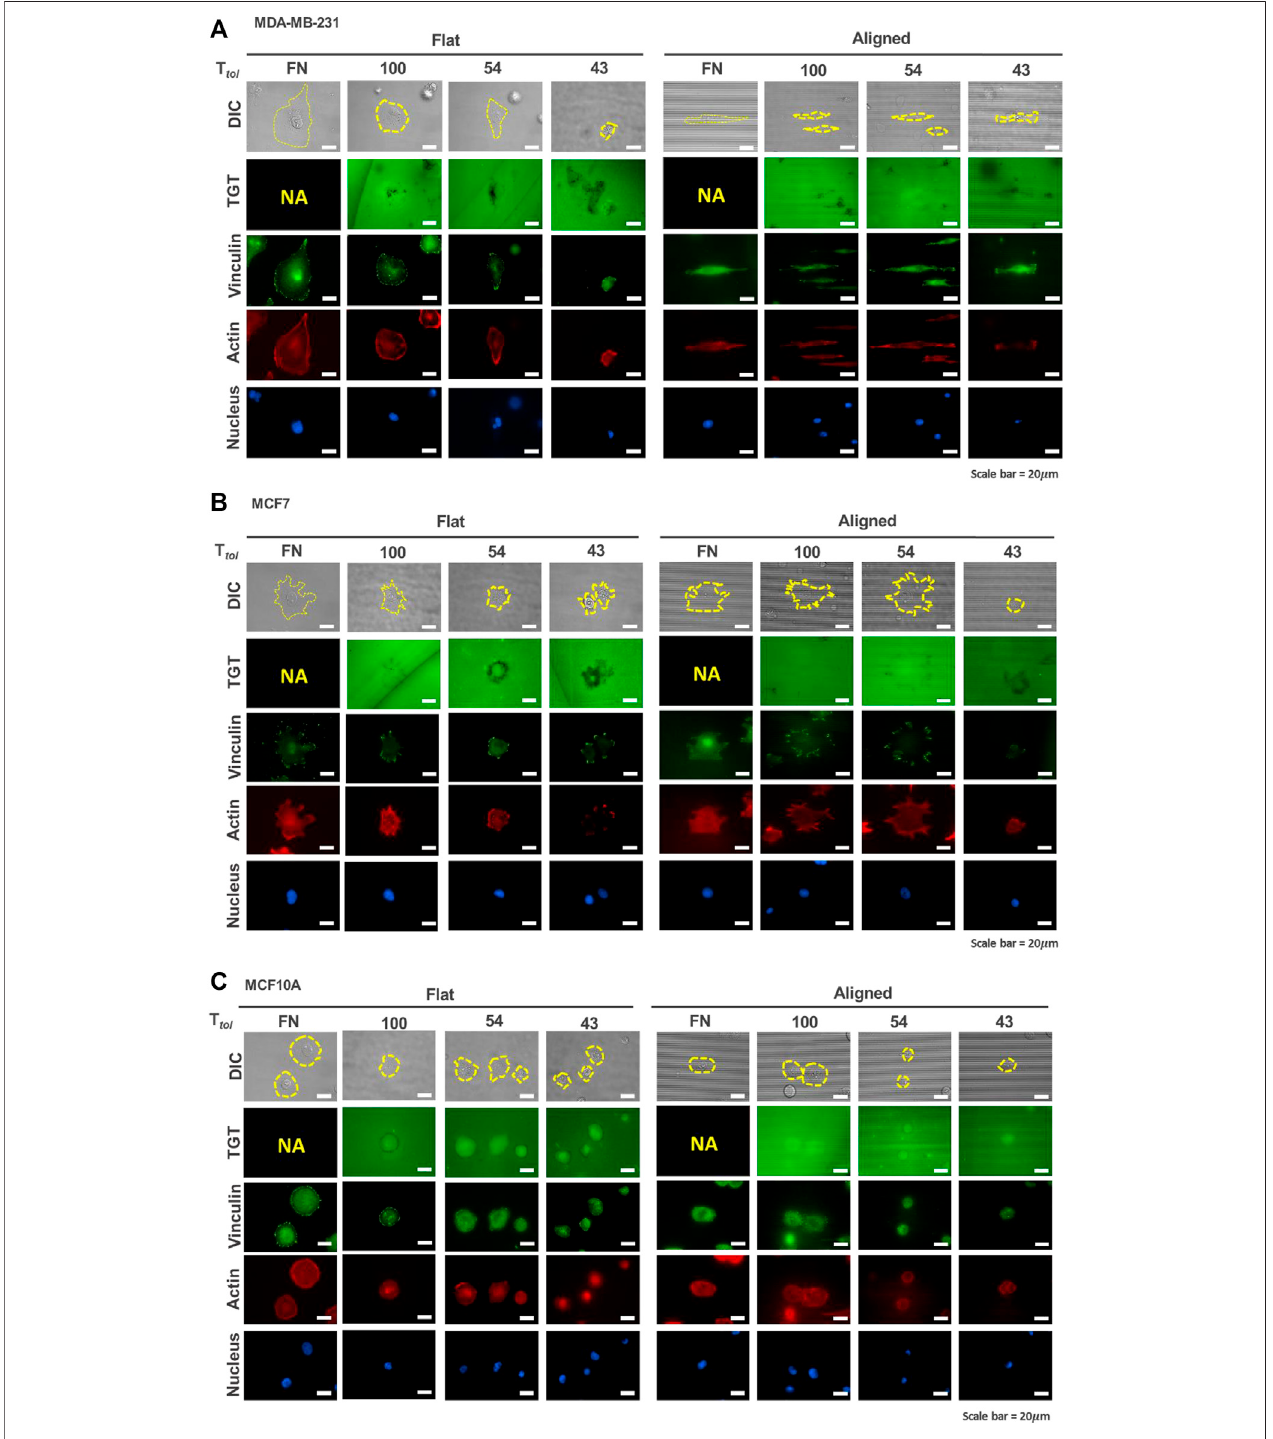
FIGURE 2 | Mapping of integrin tension of human breast epithelial cells during adhesion on fl at and nanopatterned surfaces. Cell adhesion to nanosurfaces with different T tol (43, 54, and 100 pN) induced distinctive rupture patterns. Fluorescent signal loss in the TGT image channel occurs when strong integrin tensions greater than T tol are applied to the integrin-ligand bonds due to the activity of invadopodia or force transmission through the focal adhesion indicated by using a focal adhesion marker, vinculin. MDA-MB-231 cells (A) caused TGT ruptures on the ventral surface of cells and at the cell periphery, while MCF7 (B) and MCF10A (C) formed rupture patterns mostly at their cell edges. Scale bar, 20